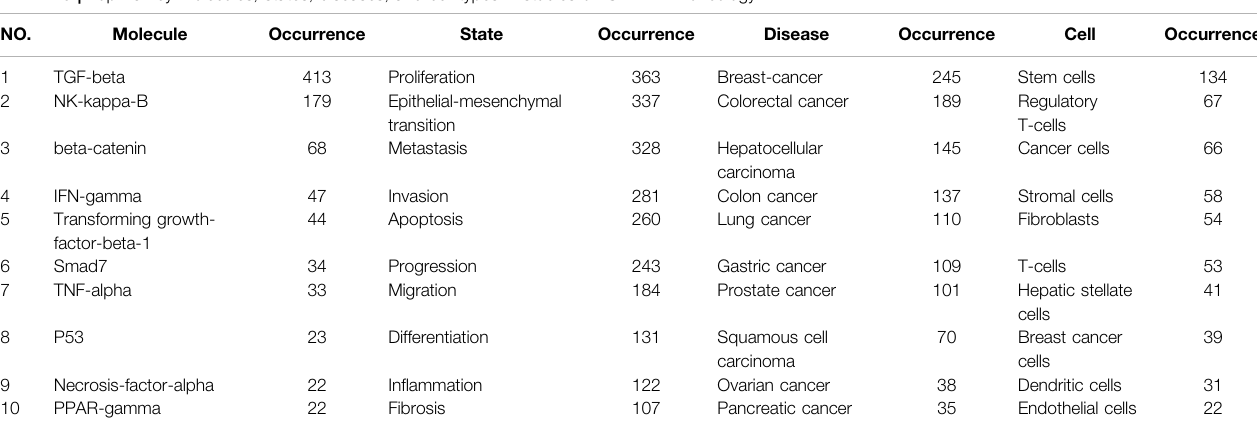
TABLE 5 | Top 10 key molecules, states, diseases, and cell types in studies on SMAD7 in oncology.